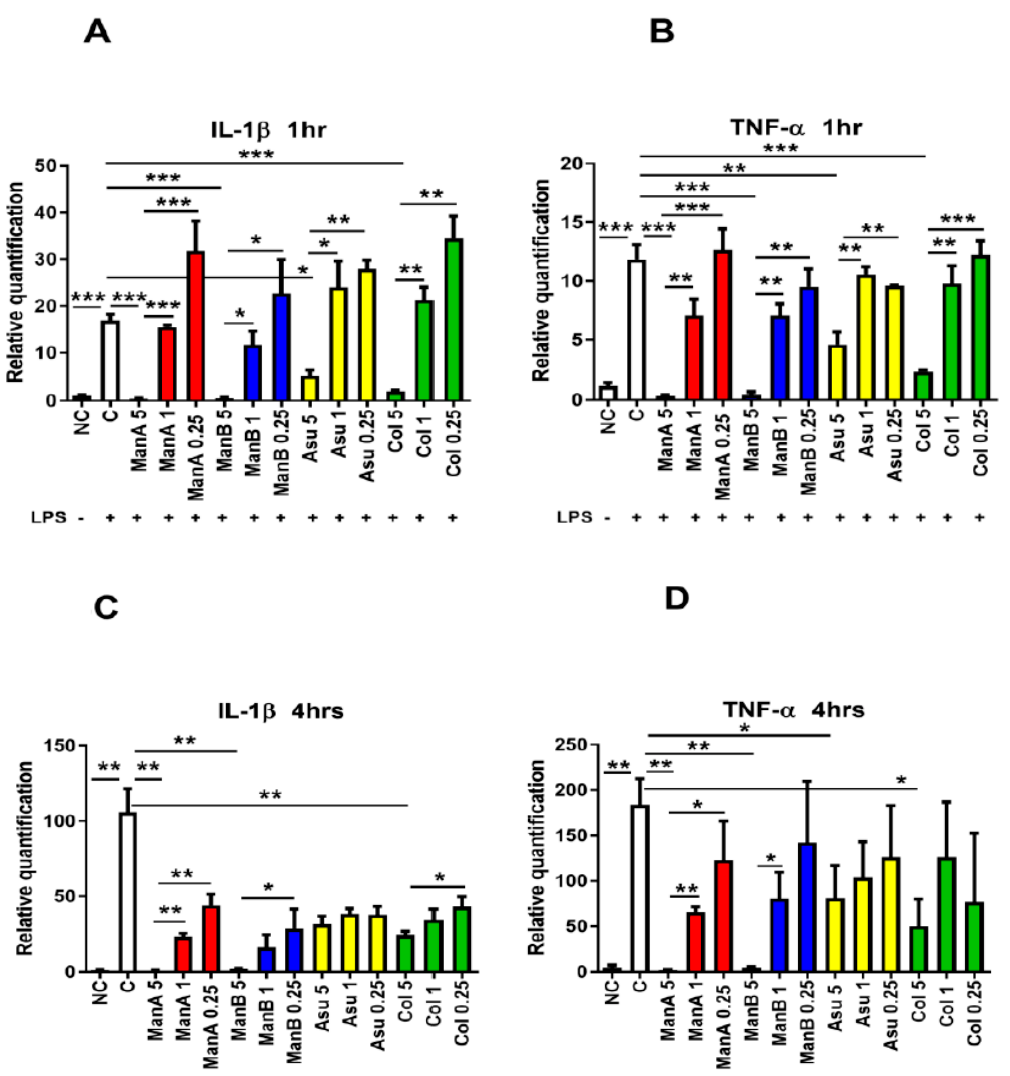
Figure 3. The effect of manumycin-type metabolites on gene expression of pro-inflammatory markers in THP-1 cells. THP-1 cells were stimulated with LPS and the effect of different concentrations of distinct manumycin-type metabolites on downregulation of expression of Il1b and Tnfa was tested by quantitative real-time PCR after 1 and 4 h stimulation. ( A ) the impact of manumycin-type metabolites on gene expression of Il1b in THP-1 cells after 1 h stimulation; ( B ) the impact of manumycin-type